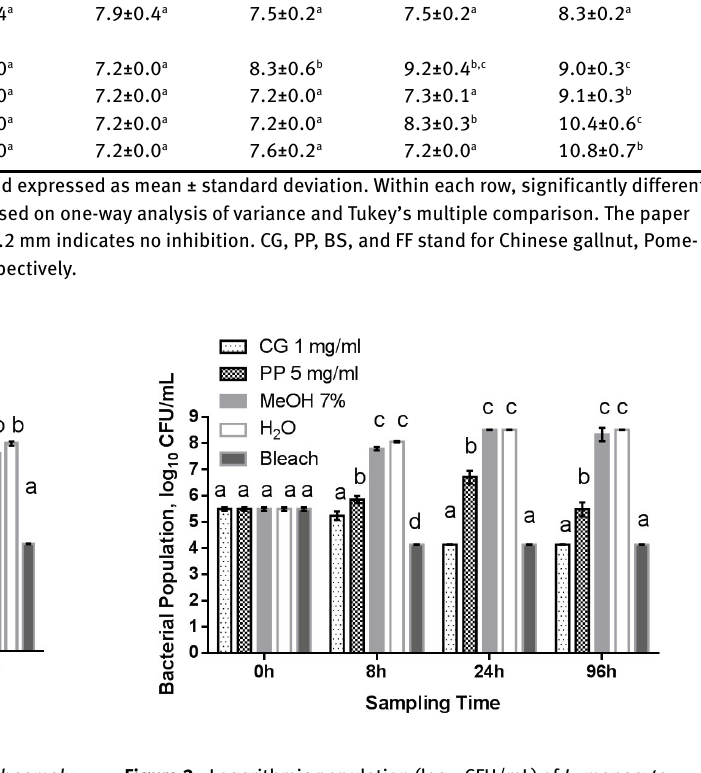
CFU/mL) of L. monocyto- CFU/mL) of V. parahaemoly- Figure 2: Logarithmic population (log Figure 1: Logarithmic population (log 10 10 genes in broth with plant extract treatments, after 0, 8, 24 and 96 ticus in tryptic soy broth (TSB) with plant extract treatments, after h incubation at 37±1°C. The initial populations (0 h) of bacteria 0, 8, 24 and 96 h incubation at 37 ± 1°C. The initial populations (0 cultures were calculated from the plate count of the inoculum. Starting from 8 hours, Chinese gall (CG) and pomegranate peel (PP) treatments significantly reduced the bacterial growth (P < 0.001). Error bar represents standard deviation. At each sampling time, populations marked with the same lowercase letter are not signifi- cantly different (P > 0.05) from each other